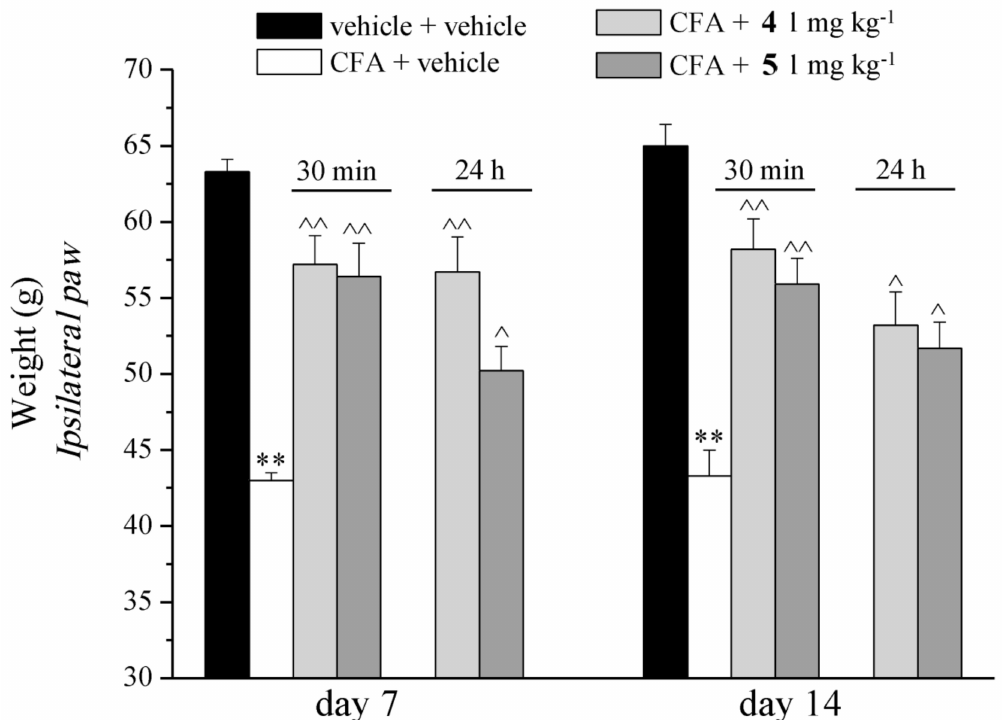
Figure 1. Preventive per os pain reliever e ff ect of compounds 4 and 5 in a Complete Freund’s Adjuvant (CFA) i.a. injection-induced rheumatoid arthritis (RA) model in rats. Paw pressure test was used to assess the hypersensitivity toward noxious mechanical stimulus. Compounds 4 and 5 (both 1 mg kg − 1 ) were suspended in 1% carboxymethylcellulose sodium salt (CMC) and orally daily administered starting on the day of CFA i.a. injection. Measurements were performed on day 7 and 14. The control animals were treated with vehicle. The value represent the mean of eight rats performed in two di ff erent experimental sets. ** p < 0.01 vs. vehicle + vehicle-treated animals; ˆ p < 0.05 and ˆˆ p < 0.01 vs. CFA + vehicle-treated